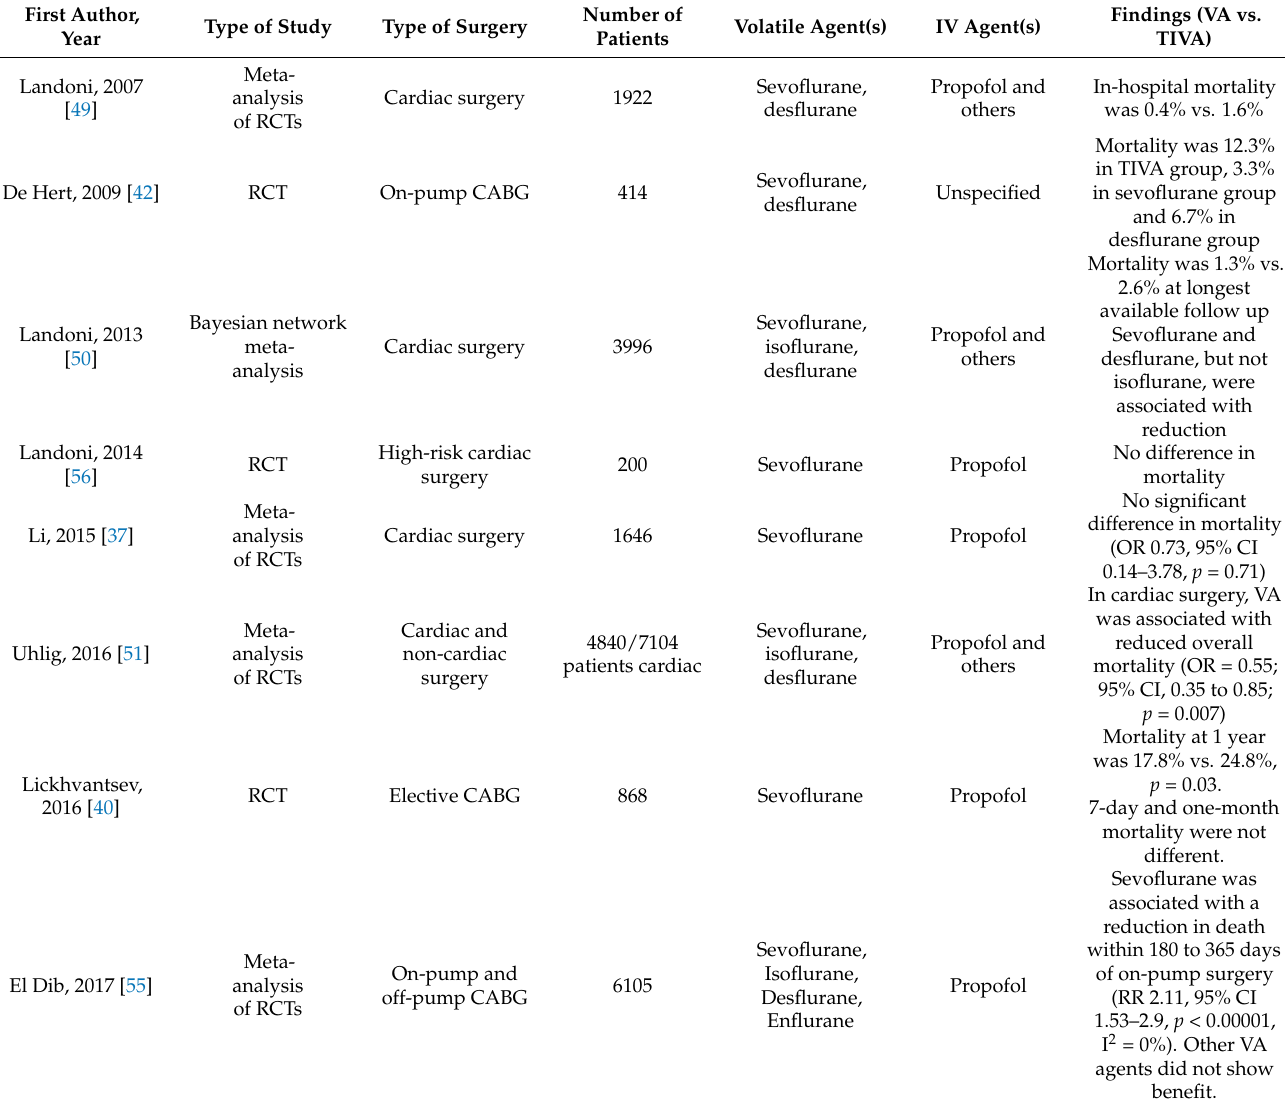
Table 1. Selected studies comparing mortality between VA and